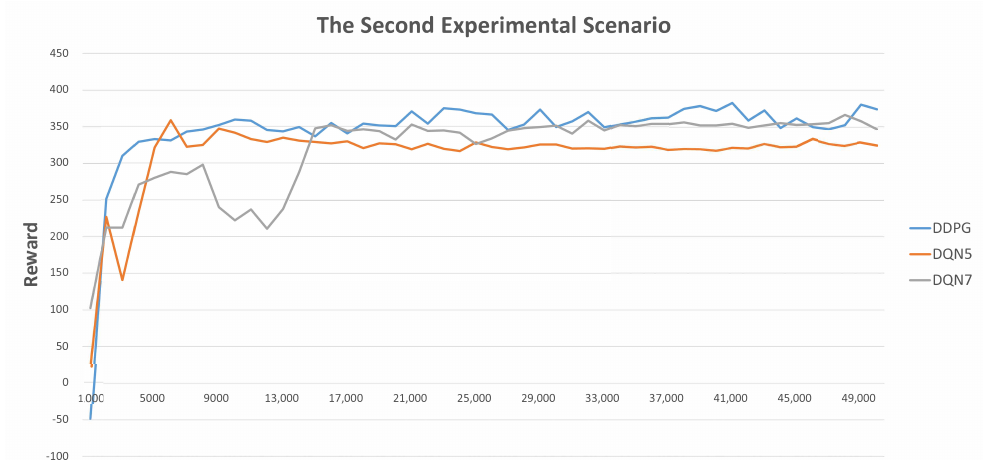
Figure 5. The statistics of average rewards in the first experimental scenario.